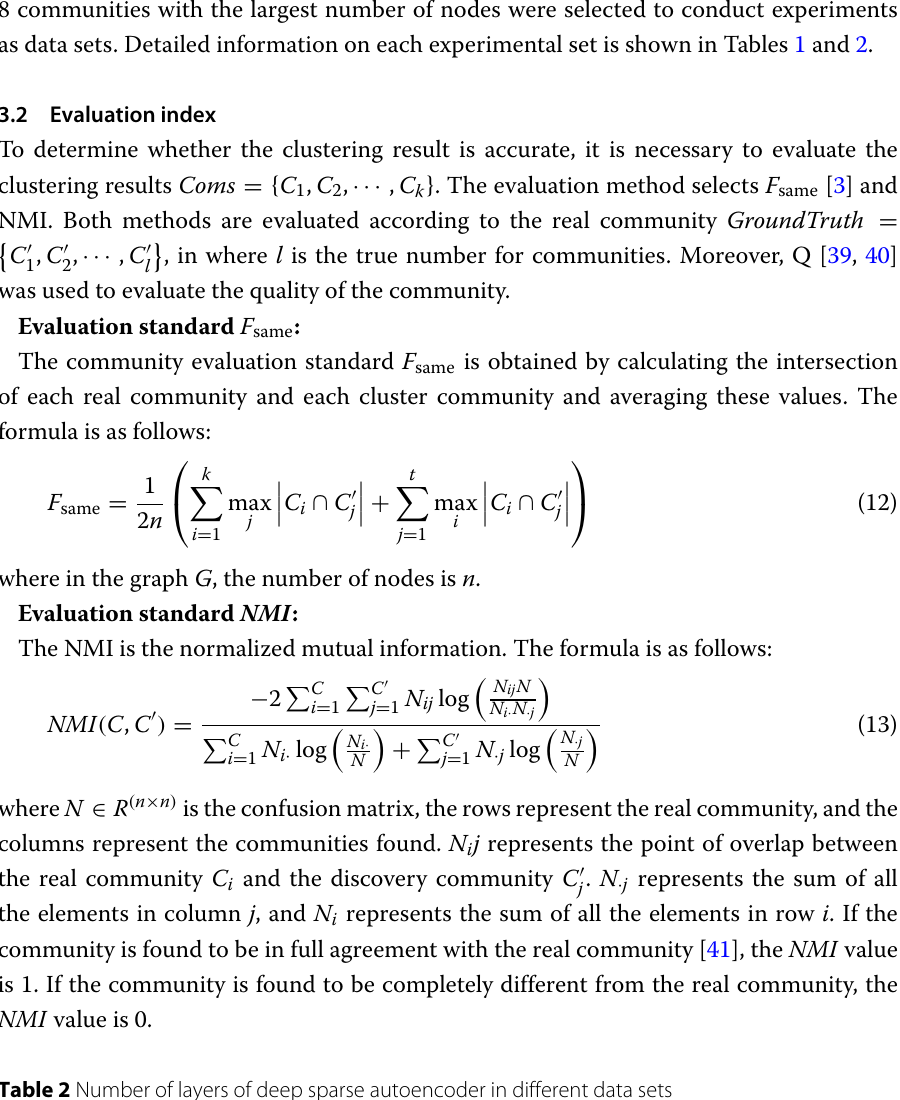
Table 2 Number of layers of deep sparse autoencoder in different data sets Data set Number of